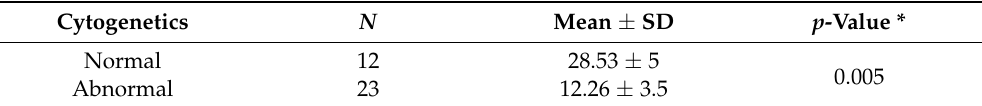
Table 2. Comparison between cytogenetic categories with regard to CD200 expression. Cytogenetics N Normal